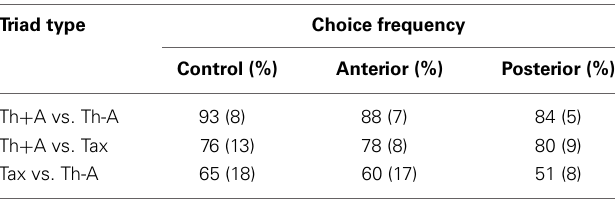
Table 2 | Percentage of participants selecting the dominant choice as a function of triad